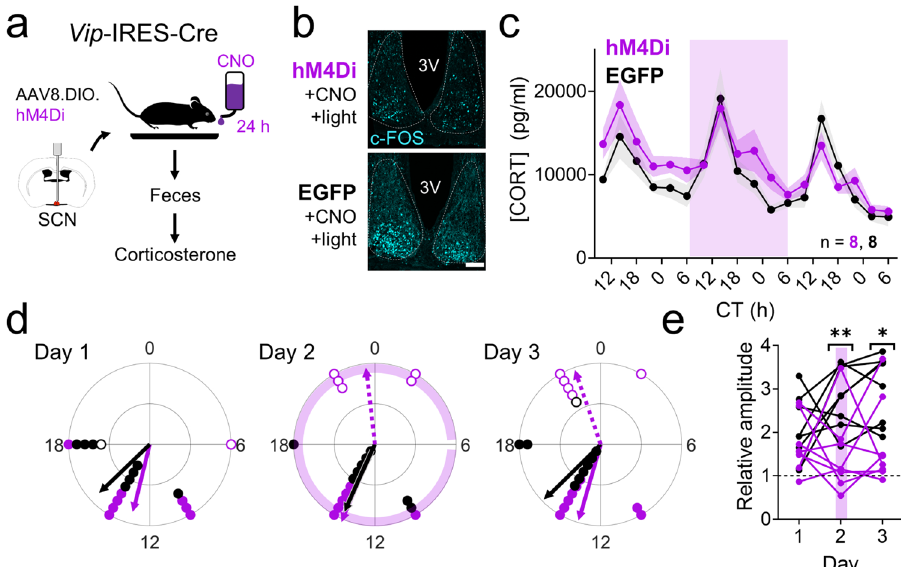
Fig. 5 Silencing of SCN VIP neurons augments circadian rhythms in corticosterone during the early morning. a Schematic for fecal corticosterone collection and chemogenetic SCN inhibition. b c-FOS immunoreactivity ( n = 4 replicates, cyan) after clozapine-N-oxide (CNO) administration 30 min before a 15 min light pulse at CT (circadian time) 12 in Vip Cre/ + + hM4Di (hM4Di, top) and Vip Cre/ + + EGFP (EGFP, bottom) mice. 3V third ventricle. Scale bar = 100 µ m. c Corticosterone rhythms over three days in EGFP (black, n = 8) and hM4Di mice (purple, n = 8). Lines and shading depict mean ± SEM. Purple shading, time of ad libitum exposure to CNO in the drinking water. Mixed-effects model, p = 0.066. d Rayleigh plots of the fi rst ( fi lled dots, solid lines) and second (open dots, dashed lines) corticosterone peaks in EGFP (black, fi rst peak times days 1 – 3 CTs 15.0, 13.5, 14.9, Rayleigh test, p = 0.004, 0.002, <0.001 on days 1, 2, and 3, respectively; no signi fi cant second peak times) and hM4Di (purple, fi rst peak times days 1 – 3 CTs 12.9, 13.5, 13.1, Rayleigh test, p = 0.004, <0.001, <0.001 on days 1, 2, and 3, respectively; second peak times days 2 – 3 CTs 23.6, 22.7, Rayleigh test, p = 0.013, 0.007 on days 2 and 3, respectively) mice on each day of collection. e The relative amplitude of the corticosterone rhythm (the ratio of the peak level at CT 10-18 divided by the peak level at CT 22-6) in EGFP (black) and hM4Di (purple) mice on each day of collection. Purple line depicts the day of ad libitum exposure to CNO in the drinking water for 24 h. Two-way repeated-measures ANOVA with post-hoc Sidak ’ s multiple comparisons test, * p = 0.010, ** p = 0.006. Source data are provided as a Source Data fi